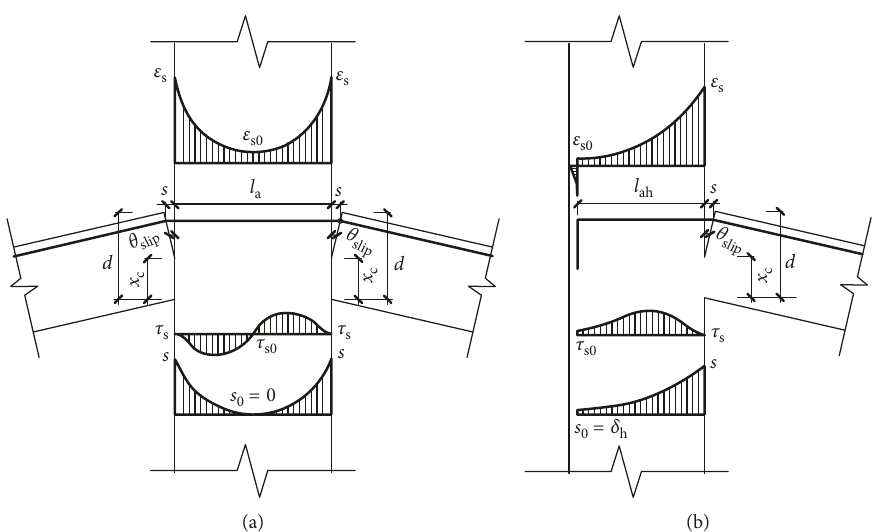
Figure 10: Strain penetration of the longitudinal tensile reinforcement inside (a) interior beam-column connection and (b) exterior beam- column connection.